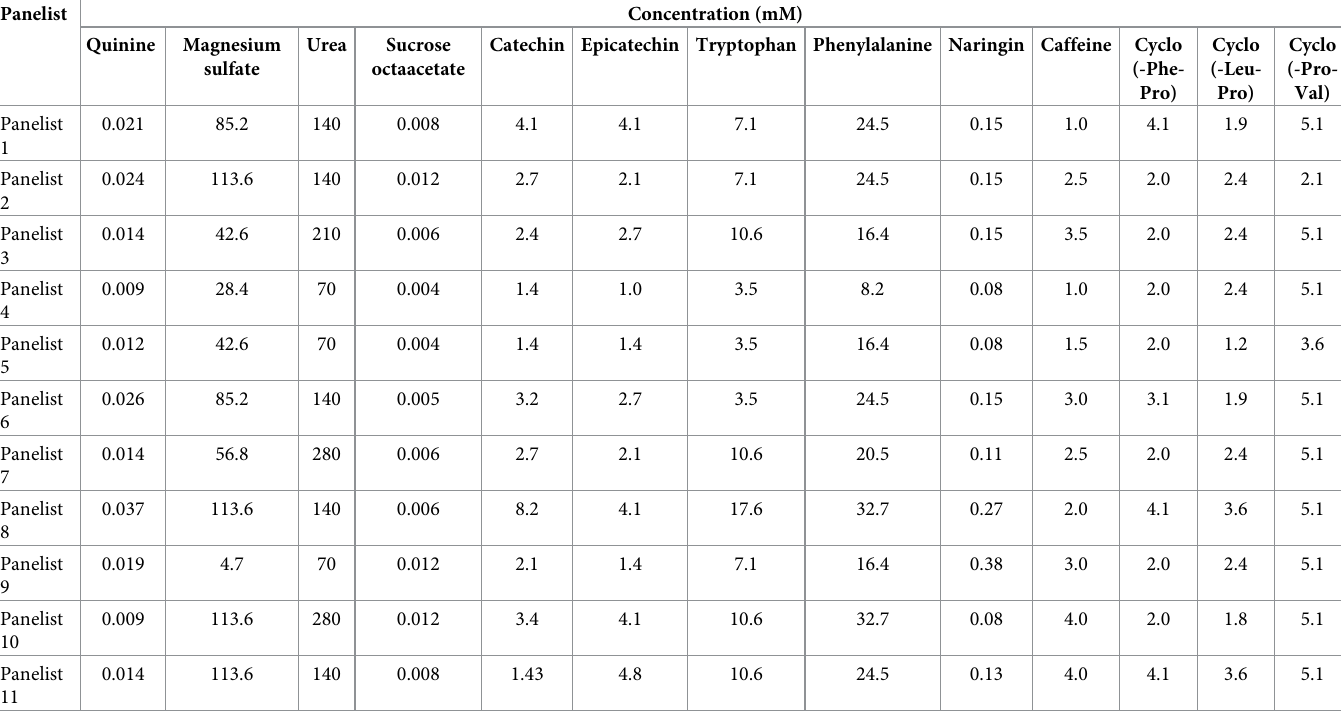
Table 1. Individual titration (mM) procedure for intensity matching of bitter compounds.